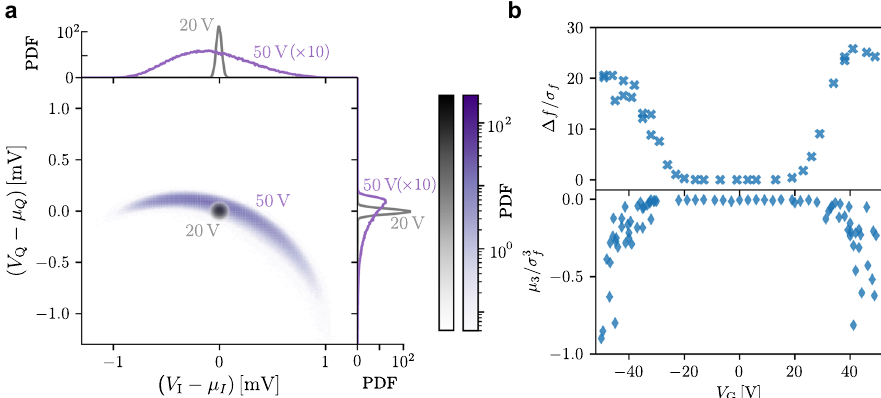
Fig. 3 Histogram analysis of the voltage noise and reconstructed noise of the resonance frequency at 10 mK. a An example of two-dimensional probability density function (PDF) of a normal deviate of the voltage noise obtained from the homodyne detection of the transmitted signal at a frequency corresponding to the w.p. in Fig. 2a for V G = 20 V and V G = 50 V. Side insets show the corresponding one-dimensional PDFs for V I and V Q components of the voltage noise for both values of the gate voltage. b Gate voltage dependence of the normalised frequency shift and standardised third-moment (skewness) of the frequency fl uctuations. Both are normalised to the variance of the frequency fl